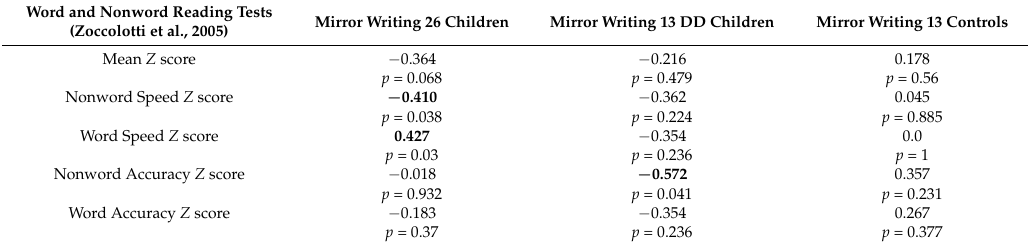
Table 3. Correlations between mirror writing and reading indices (rows) in three groups: all 26 children, 13 with DD, 13 controls. Correlation coefficients larger than 0.5 in the whole group and 0.4 in single groups are highlighted in